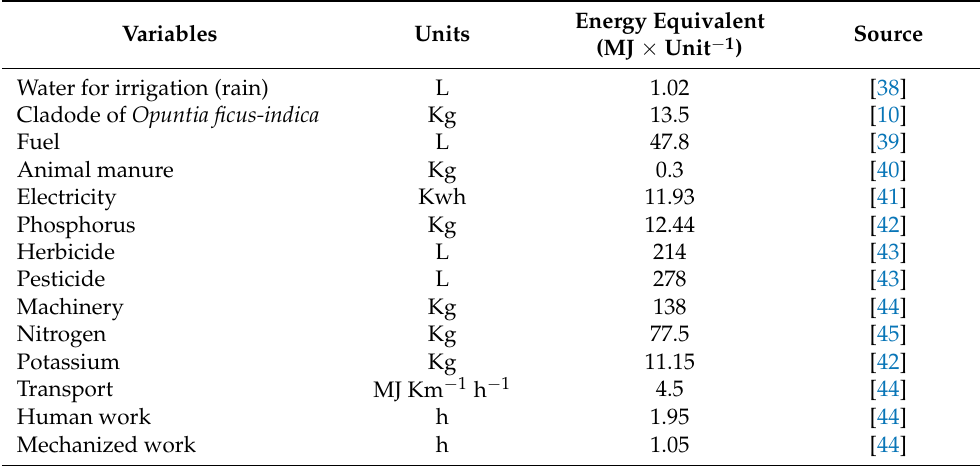
Table 2. Defining the characteristics of the cultivation system.